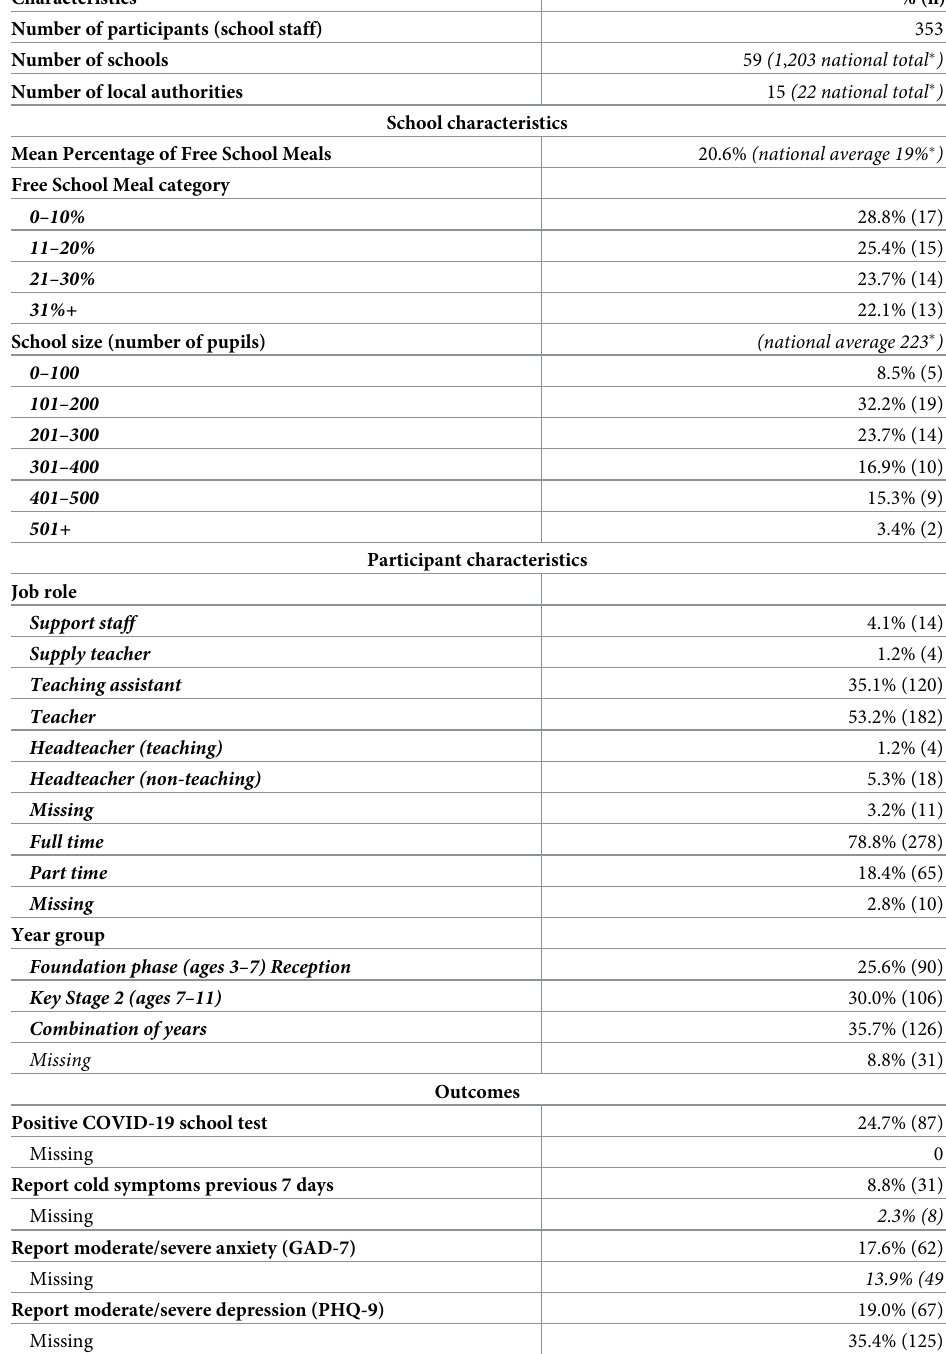
Table 1. Demographics of survey respondents; � obtained from Welsh Government data online